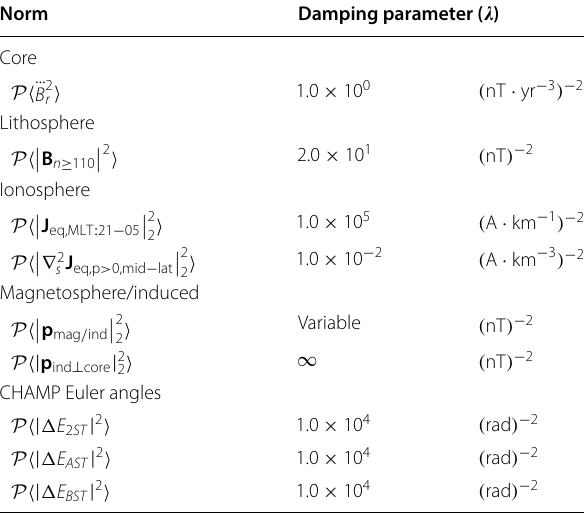
Table 3 CM6 damping parameter values Norm